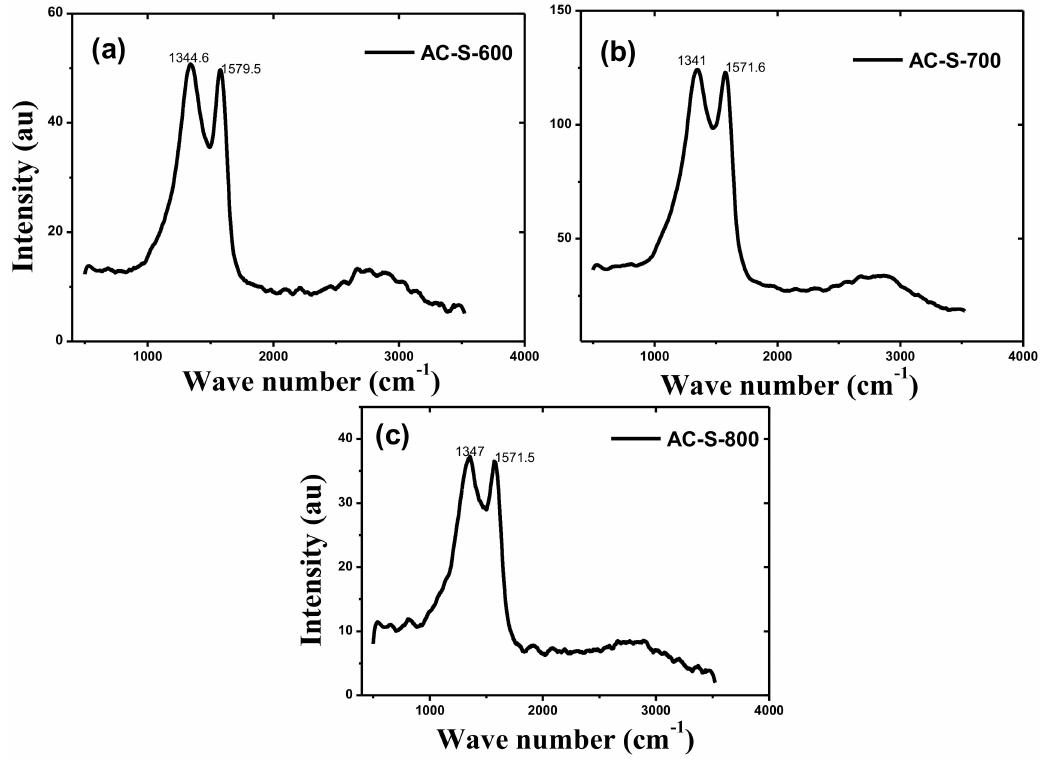
Figure 6. Raman spectra for ( a ) AC-S-600, ( b ) AC-S-700 and ( c ) AC-S-800 activated carbon